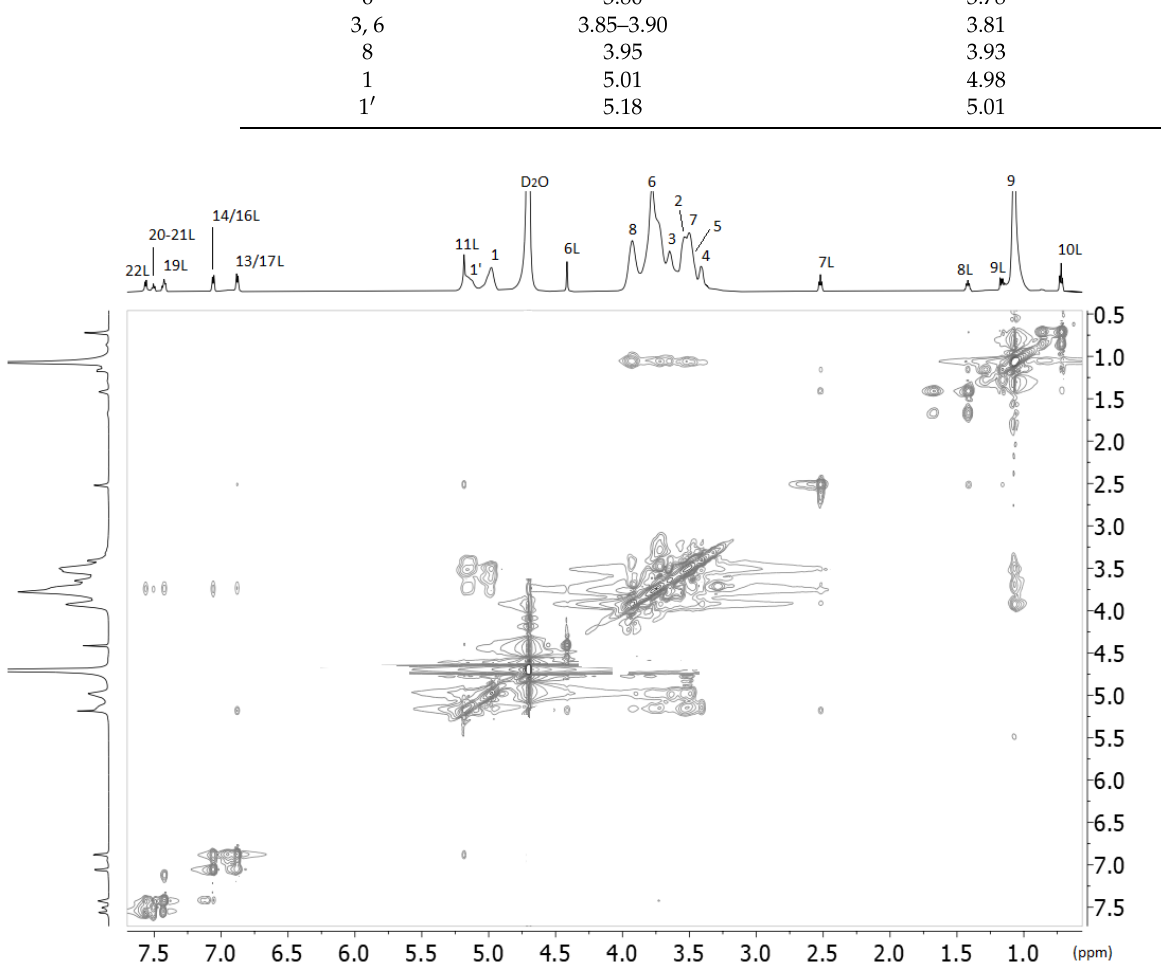
Figure 4. 2D ROESY spectra of the losartan and 2-HP- β -CD complex obtained with 700 MHz Bruker spectrometer using D 2 O solvent and at 25 °C. Table 3. The most important comparative distances in the complex obtained through 2D ROESY and DFT MD calculations.